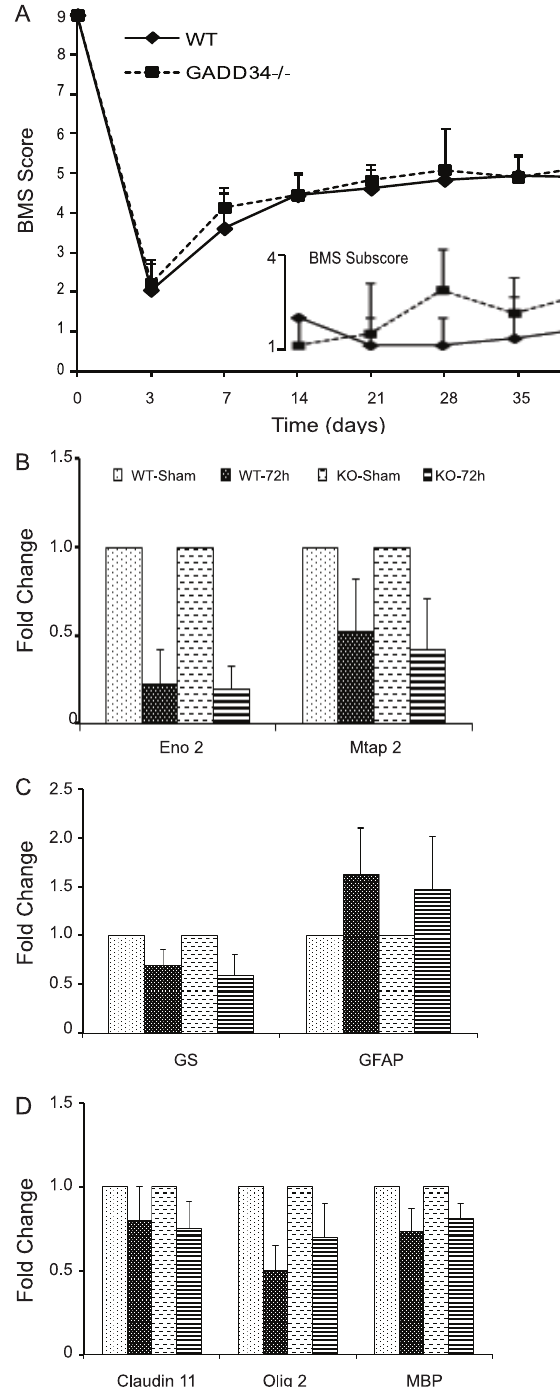
Figure 3. Locomotor assessment in GADD34 -/- mice after SCI. (A) BMS locomotor analyses performed weekly following moderate SCI did not reveal any functional recovery in GADD34 -/- mice (solid squares) compared to WT mice (solid diamonds). Analysis of BMS subscore post- SCI showed no significant differences in stepping characteristics between the two groups (inset). There is no significant difference in the neuron- (B), astrocyte-(C) and oligodendrocyte-specific (D) tran- script levels as indicated between WT and GADD34 -/- mice 72 hours post-SCI. Data (A,B) are the mean 6 SD (n=9).